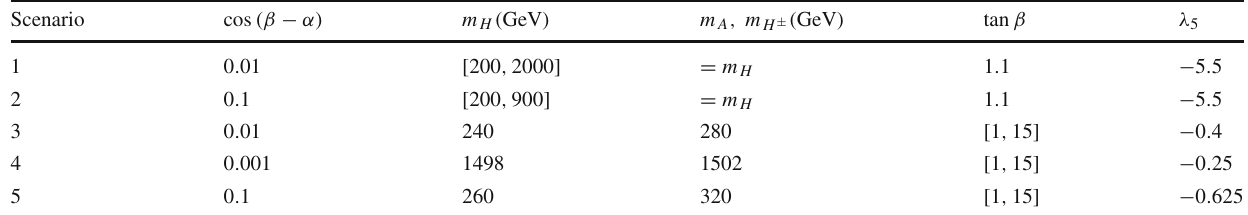
Table 3 Benchmark Scenarios used in the numerical analysis to explore the electroweak and alignment fine-tunings in the 2HDM. The fact that m A = m H ± implies λ 4 = λ 5 in all cases